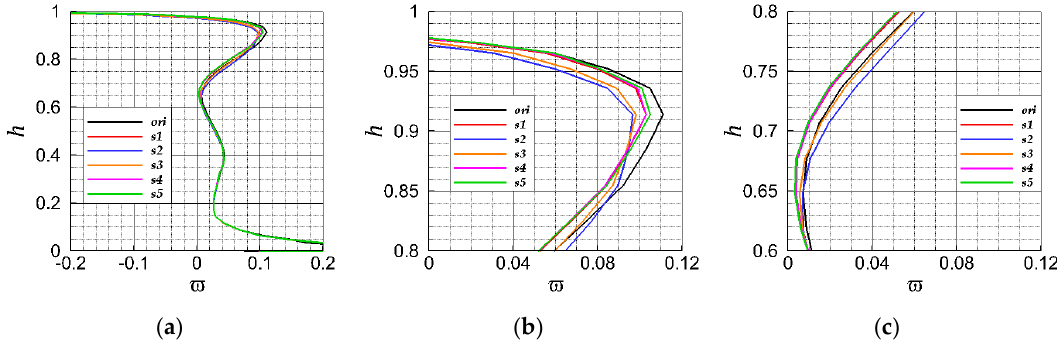
Figure 17. Comparison of the loss coefficients for the axisymmetric stator (marked as “ori”) and optimization results of different schemes (CFD results). ( a ) Map for the whole blade height; ( b ) detailed map that focused on 0.8 to 1 blade height; ( c ) detailed map that focused on 0.6 to 0.8 blade height.